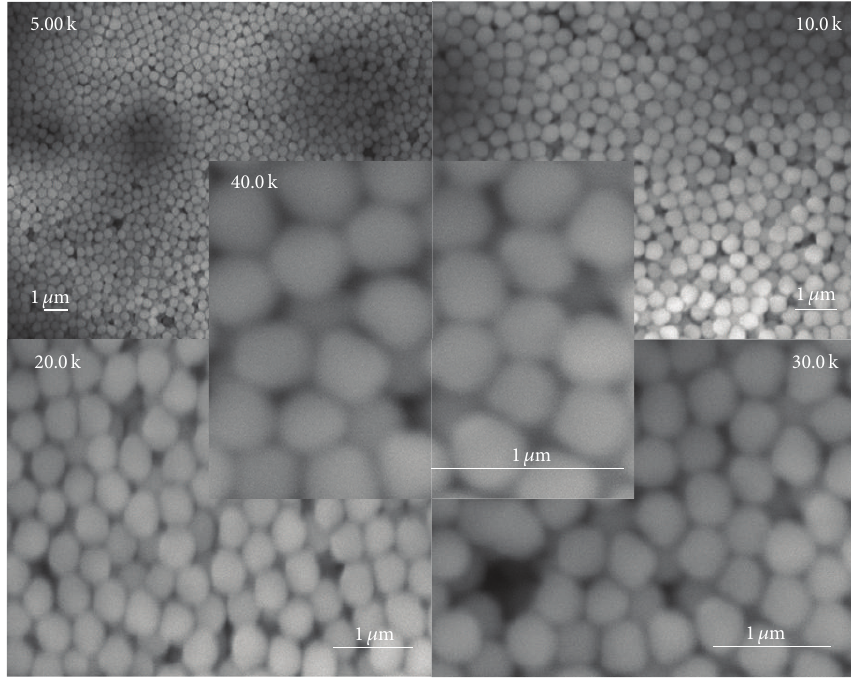
Figure 3: SEM images of SiO 2 particles at different